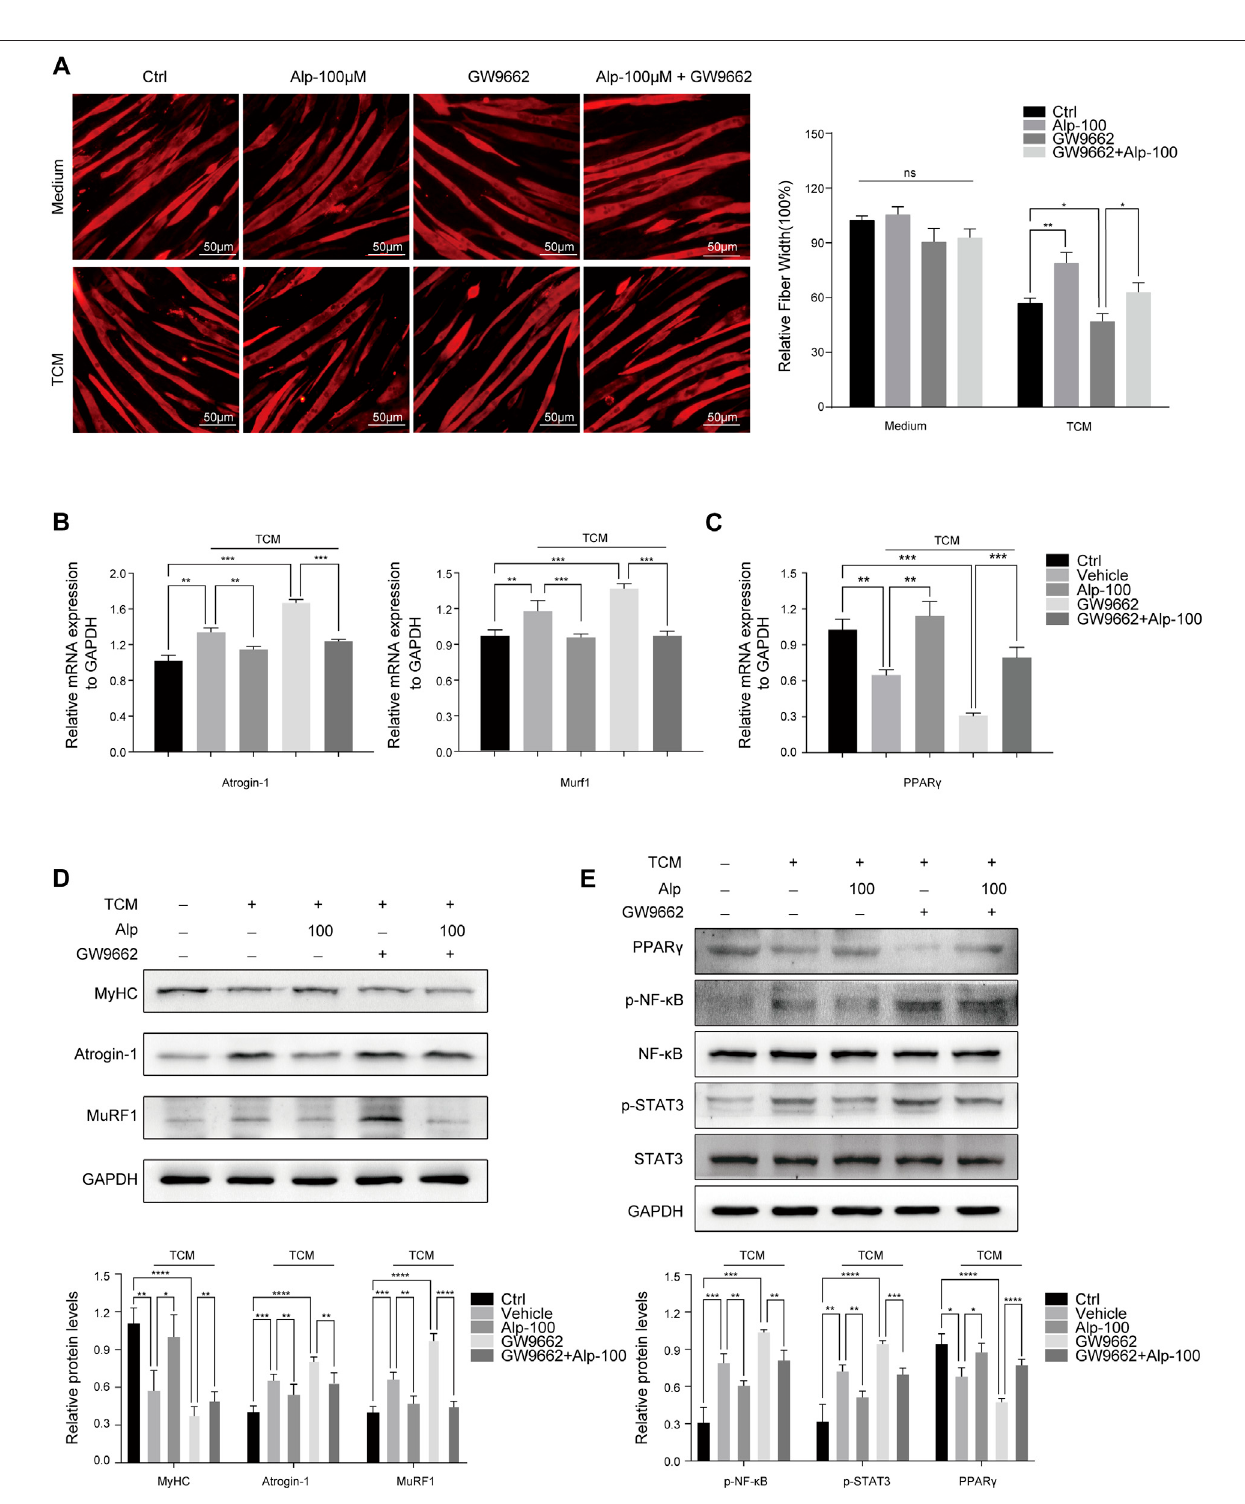
FIGURE4| AlpimprovesTCM-inducedmyotubewastingthroughPPAR γ activation.C2C12myotubeswerepretreatedwithGW9662(10 μ M)for30 minandthen stimulated by Alp (100 μ M) and LLC TCM for 48 h. (A) Representative immuno fl uorescence images for MyHC (red) are displayed (left) , and the fi ber widths were measured (right) . (B,C) The mRNA expressions of Atrogin-1, Murf1, and PPAR γ were detected by real-time PCR and normalized with GAPDH. (D,E) The levels of indicated proteins in myotube were detected by Western blot, and the band densities were measured and normalized with GAPDH or the non-phosphorylated protein forms. * p < 0.05, ** p < 0.01, *** p < 0.001, **** p < 0.0001 vs. control. ns: not signi fi cant. n (cid:1) 3.